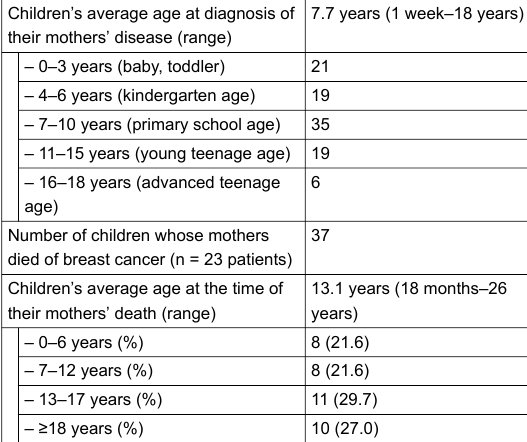
Table 5: The children of young breast cancer patients (n =